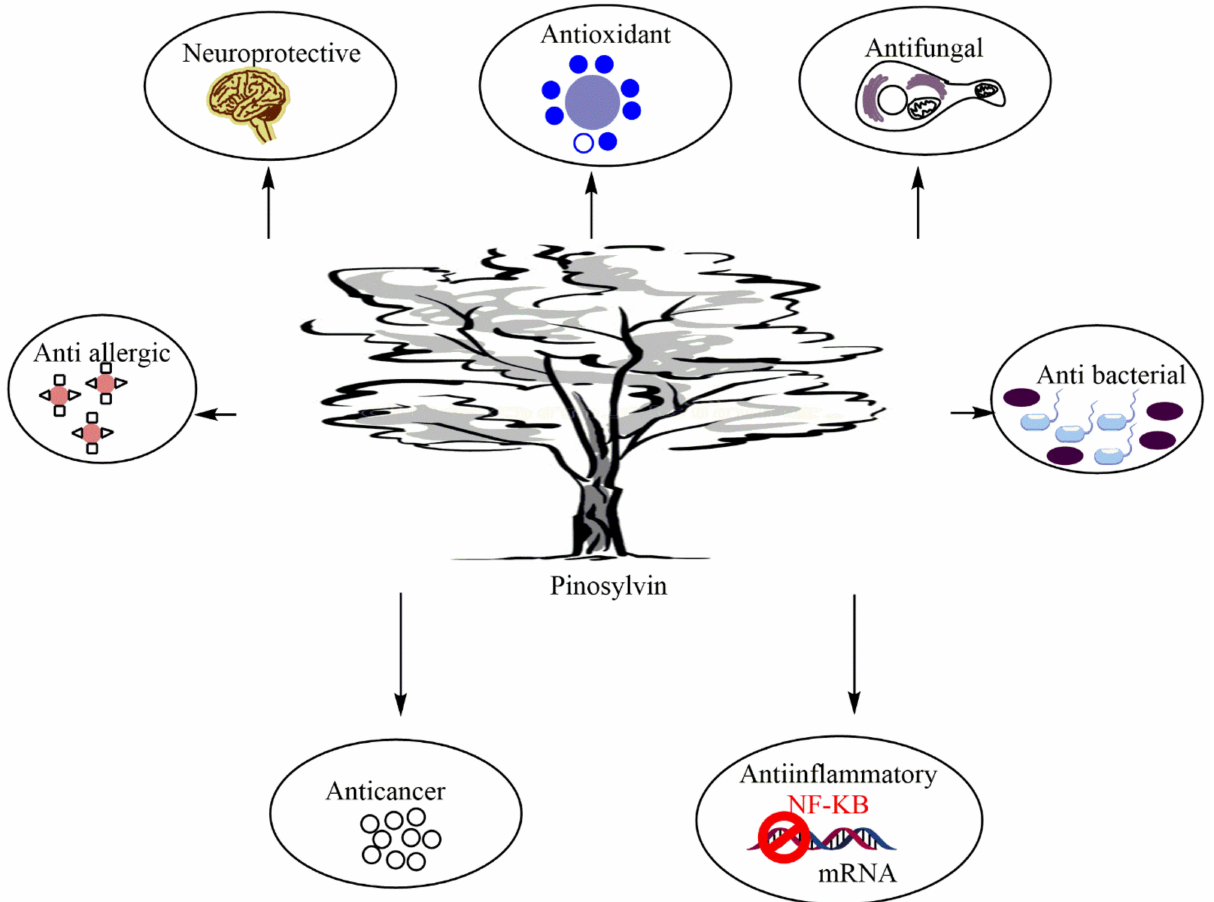
Figure 1. Major pharmacological properties of